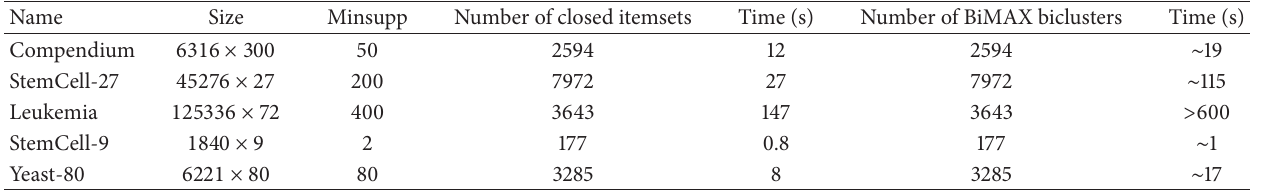
Table 2: Test runs using biological